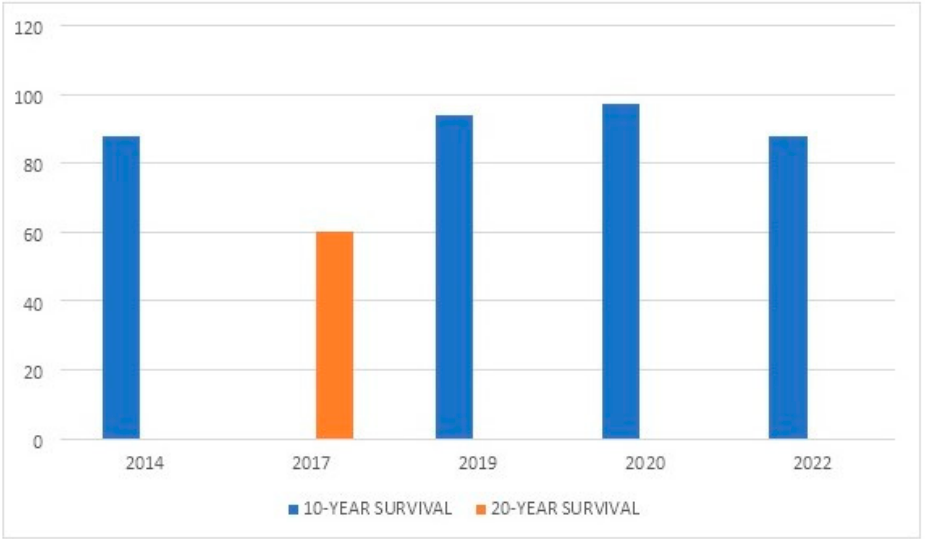
Figure 4. 10-year-, 13-year- and 20-year-rates of implant survival of total knee arthroplasty (TKA) in people with hemophilia (PWH) from 2014 to 2022.